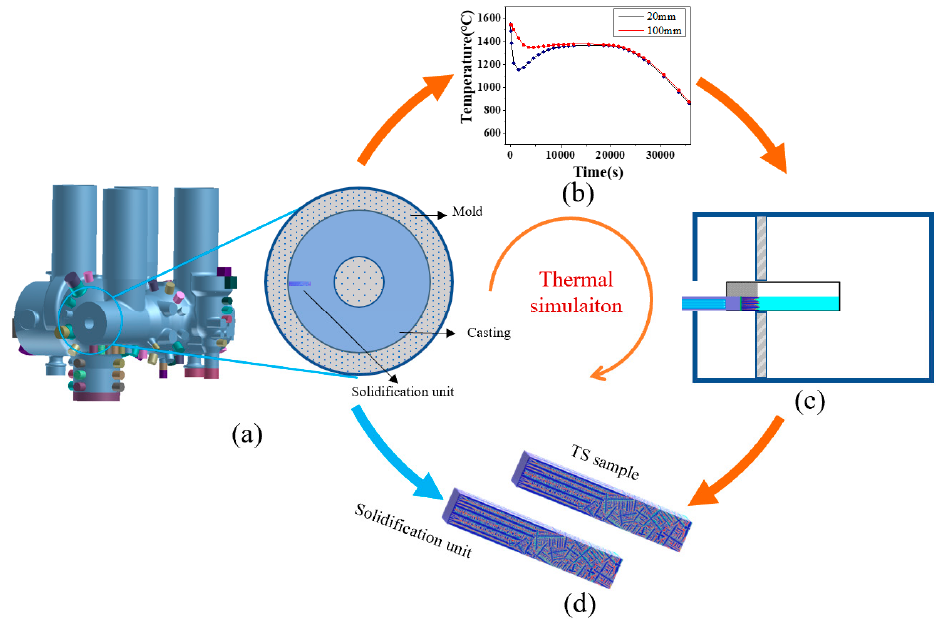
Figure 2. An illustration of the thermal simulation method: ( a ) a schematic diagram of the heavy casting and a selected “characteristic solidification unit”; ( b ) temperature curves of the cold and hot sides of a thermal simulated (TS) sample; ( c ) a schematic diagram of the thermal simulation experiment; ( d ) a “solidification unit” compared with a TS sample.